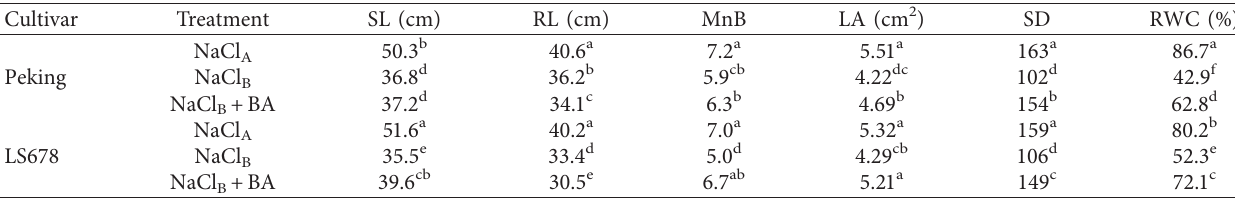
Table 1: Mean vegetative response in terms of the shoot length (SL), root length (RL), number of branches (MnB), leaf area (LA), stomatal density (SD), and relative water content of Peking and LS678 soybeans subjected to high salinity stress. Cultivar